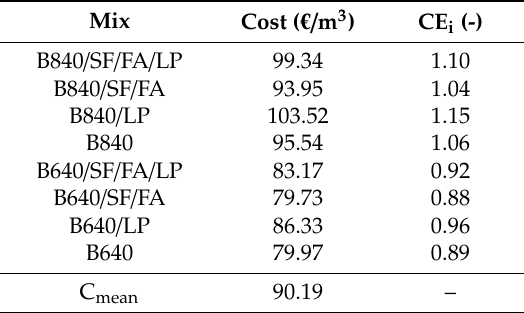
Table 9. Price of mixes.